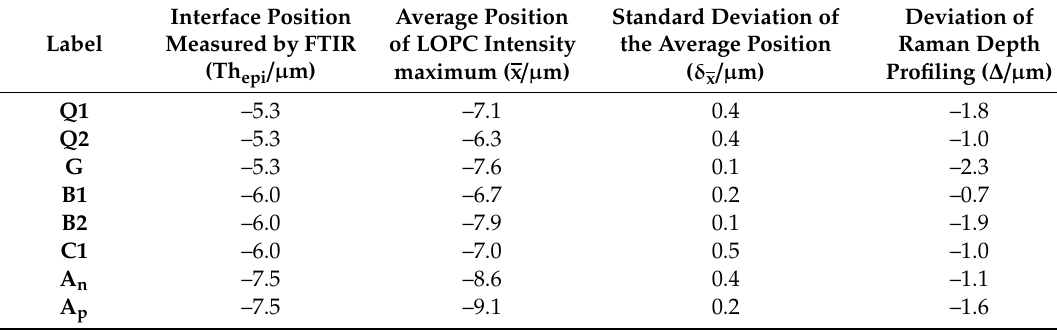
Table 3. The interface position measured by FTIR measurements, average position of the maximum of LOPC peak intensity, and the deviations of the Raman depth profiling for samples with three kinds of epitaxial thicknesses. The step of depth profiling is 0.5 µ